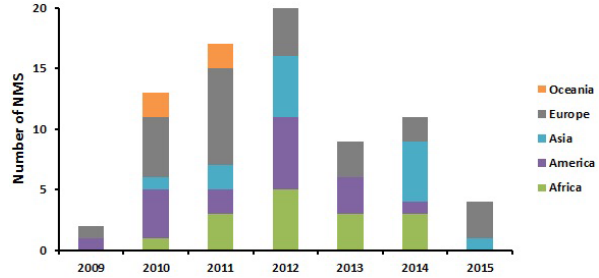
Figure 1. Percentages of NMSs which have accounts on Facebook by continents (May 2015). Dark color refers to total NMSs and light one to NMSs with Facebook account.